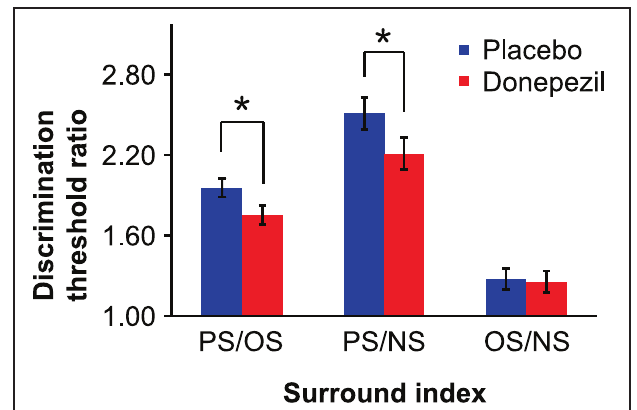
ratio of contrast discrimination thresholds for parallel and orthogonal (PS/OS), parallel and no surround (PS/NS), or orthogonal and no surround (OS/NS) conditions. ( ∗ , p < 0 . 05). Error bars represent ± 1 SEM of the within-subject difference between the placebo and donepezil conditions for each surround suppression